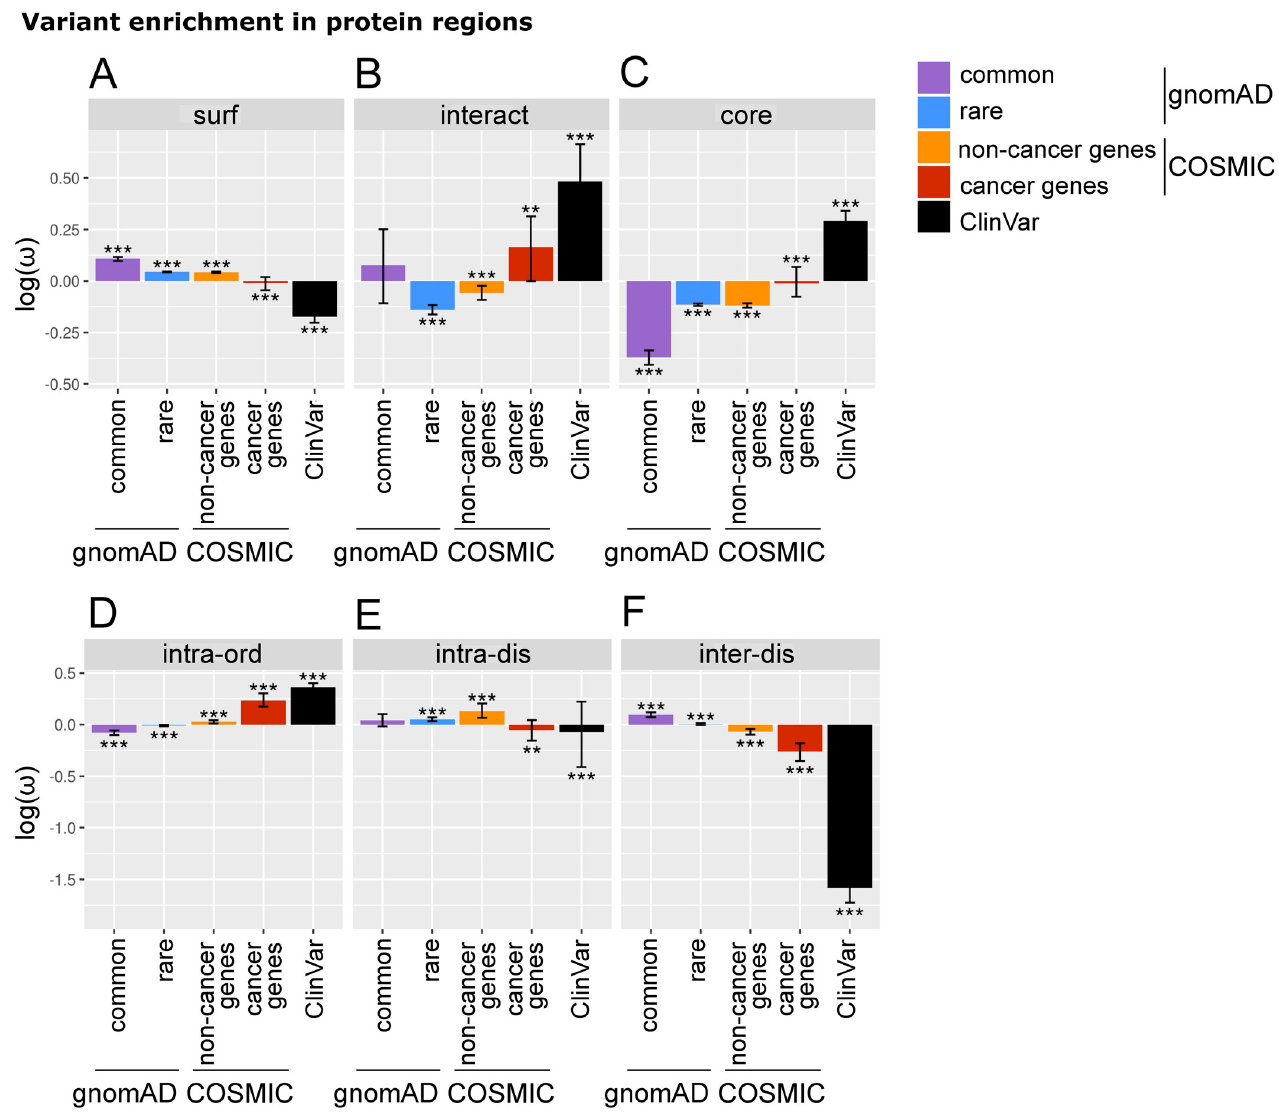
Fig 2. The localisation of variants to protein regions. (A–C) The density of mutations in different protein regions, calculated using Eq 1. Density values ( ω ) were log-transformed such that negative values indicate a depletion of missense variants, while positive values indicate enrichment. Error bars depict 95% confidence intervals obtained from bootstrapping. Significance was calculated by comparison to simulated missense variant distributions (significance level indicated by: � q -value < 0.05, �� q -value < 0.001, ��� q -value < 0.0001). Note here the COSMIC set is split into cancer genes (i.e., mutations mapping to proteins found in the COSMIC CGC) and noncancer gene subsets. Data are shown for protein surface ( surf , panel A), interacting interface ( interact , B), and core (C). (D–F) Density of mutations analogous to panels (A–C) but in regions defined by order and disorder. Data are shown here for intra-domain ordered ( intra-ord , panel D), intra-domain disordered ( intra-dis , E), and inter-domain disordered ( inter-dis , F) regions. See S2 Data for the underlying data. CGC, Cancer Gene